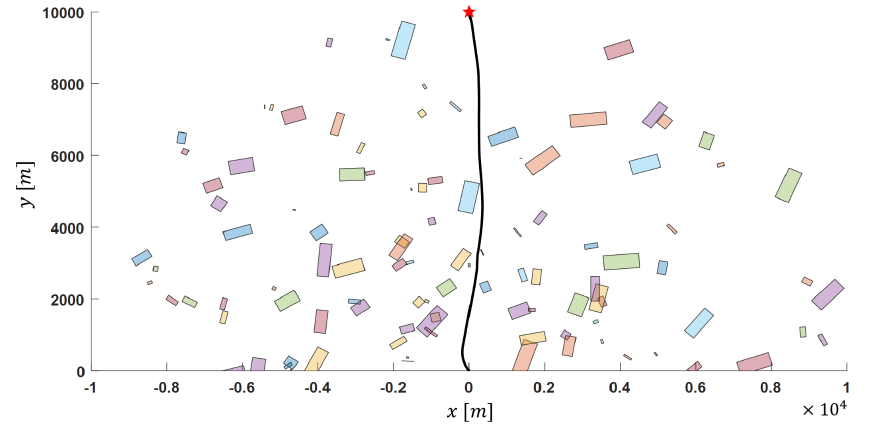
Figure 11. The trajectory of scenario